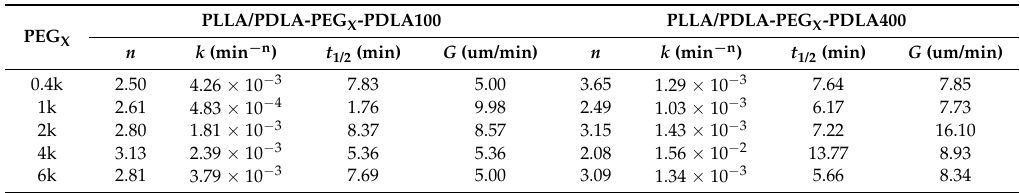
Table 2. Avrami kinetic parameters of PLLA/PDLA-PEG X -PDLA100 and PLLA/PDLA-PEG X - PDLA400 isothermally crystallized at 160 ◦ C and radial growth rate of spherulites of ( G ) of the blends isothermally crystallized at 170 ◦